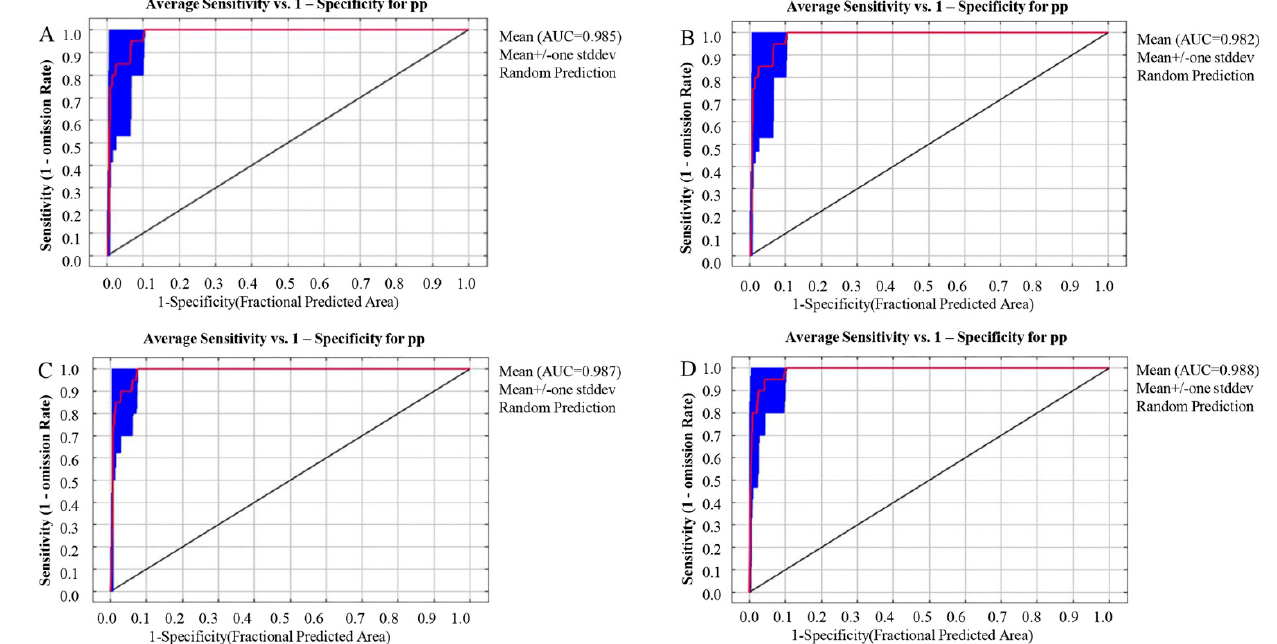
Figure 3. Predicted ROC curve of suitable leopard area under different climate models. ( A ). Predicted ROC curve of the suitable leopard area in modern Guyuan. ( B ). Predicted ROC curve of the suitable leopard area under the future rcp2.6 climate model. ( C ). Predicted ROC curve of the suitable leopard area under the future rcp4.5 climate model. ( D ). Predicted ROC curve of the suitable leopard area under the future rcp8.5 climate model.